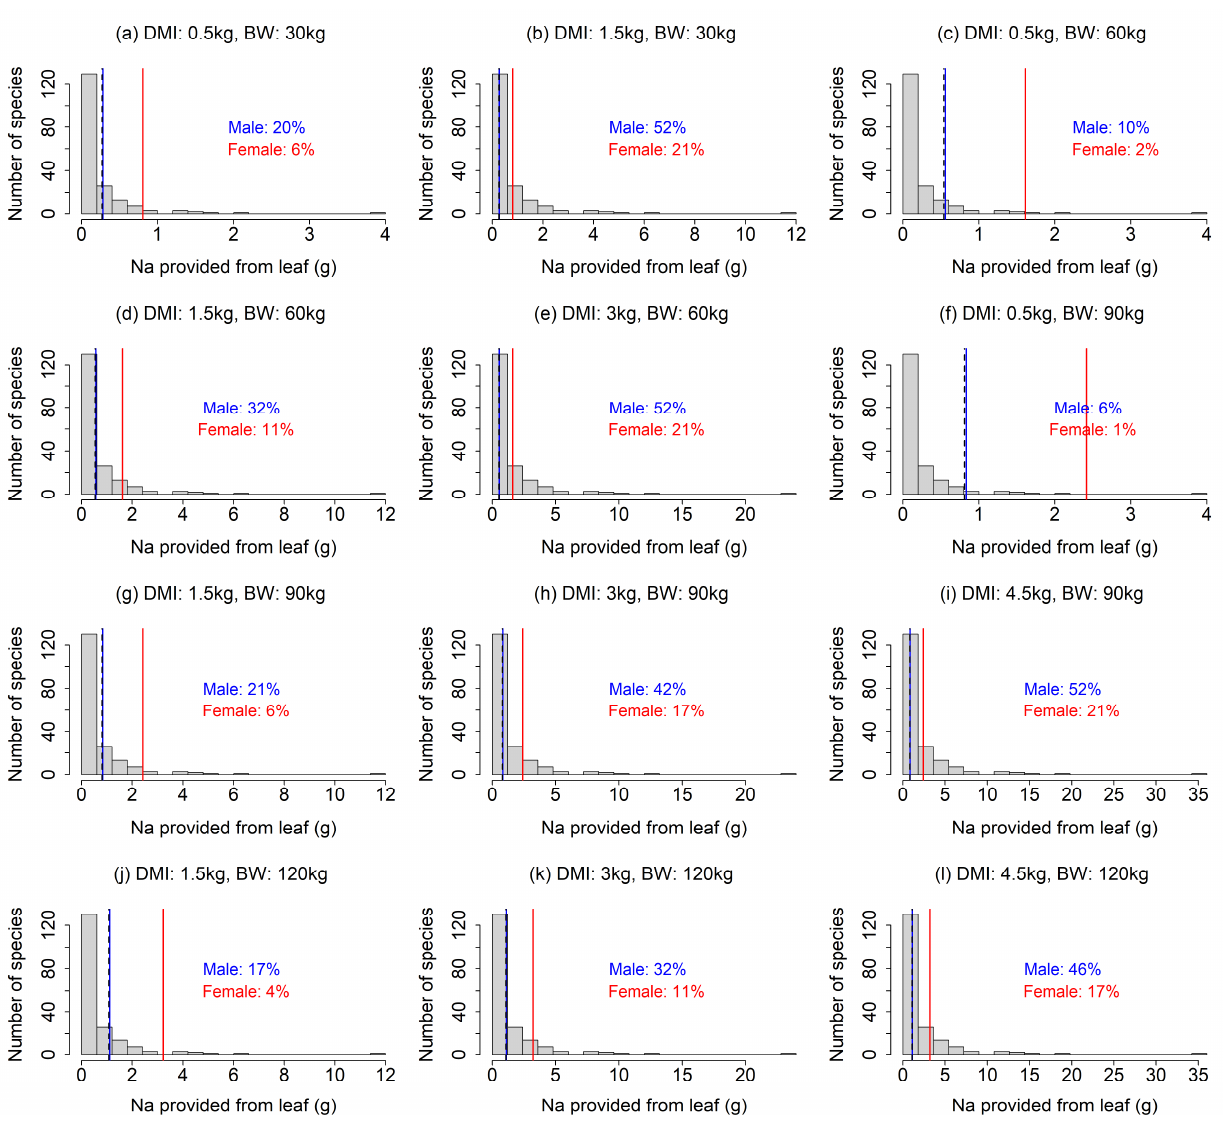
Figure 2. ( a – l ) Comparison of Na provision by feed plants and the Na requirement of sika deer under 12 scenarios (four dry matter intake levels × four body weights, excluding unrealistic scenarios). The histogram indicates the distribution of Na provision calculated from the leaves of feed plant species. The solid lines indicate the Na requirements of male (blue) and female (red) sika deer. Dashed line indicates Na requirement of females during the non-lactating period, which is equal to Na maintenance requirement for both males and females. In the figures, the percentage is the proportion of feed plant species that meet the Na requirements.